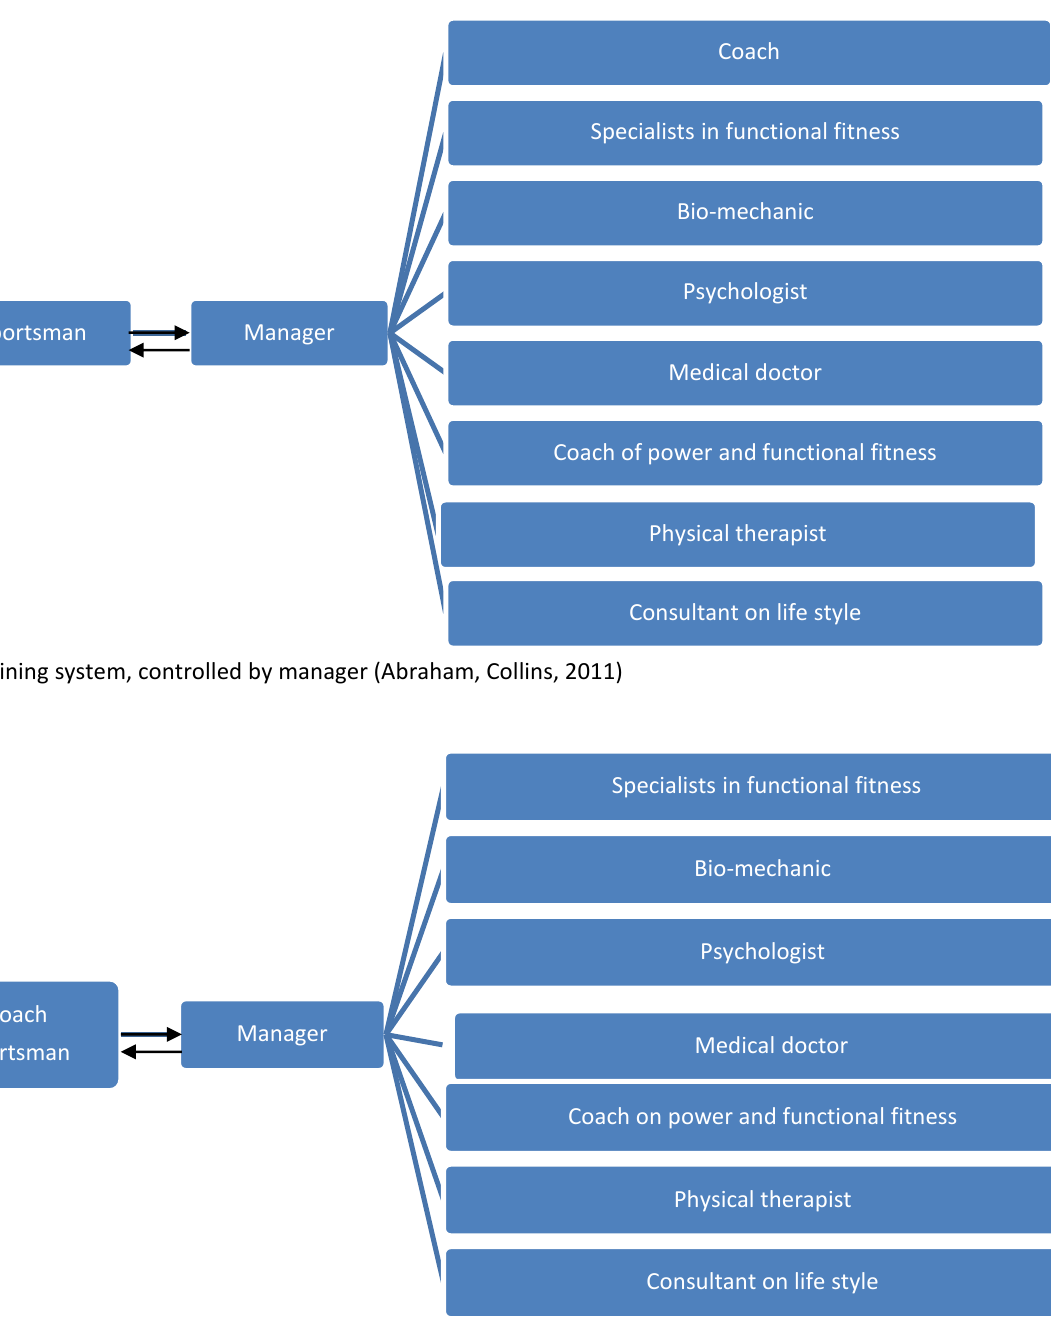
Fig.3. Training system for disunite groups, controlled by manager (Abraham, Collins,